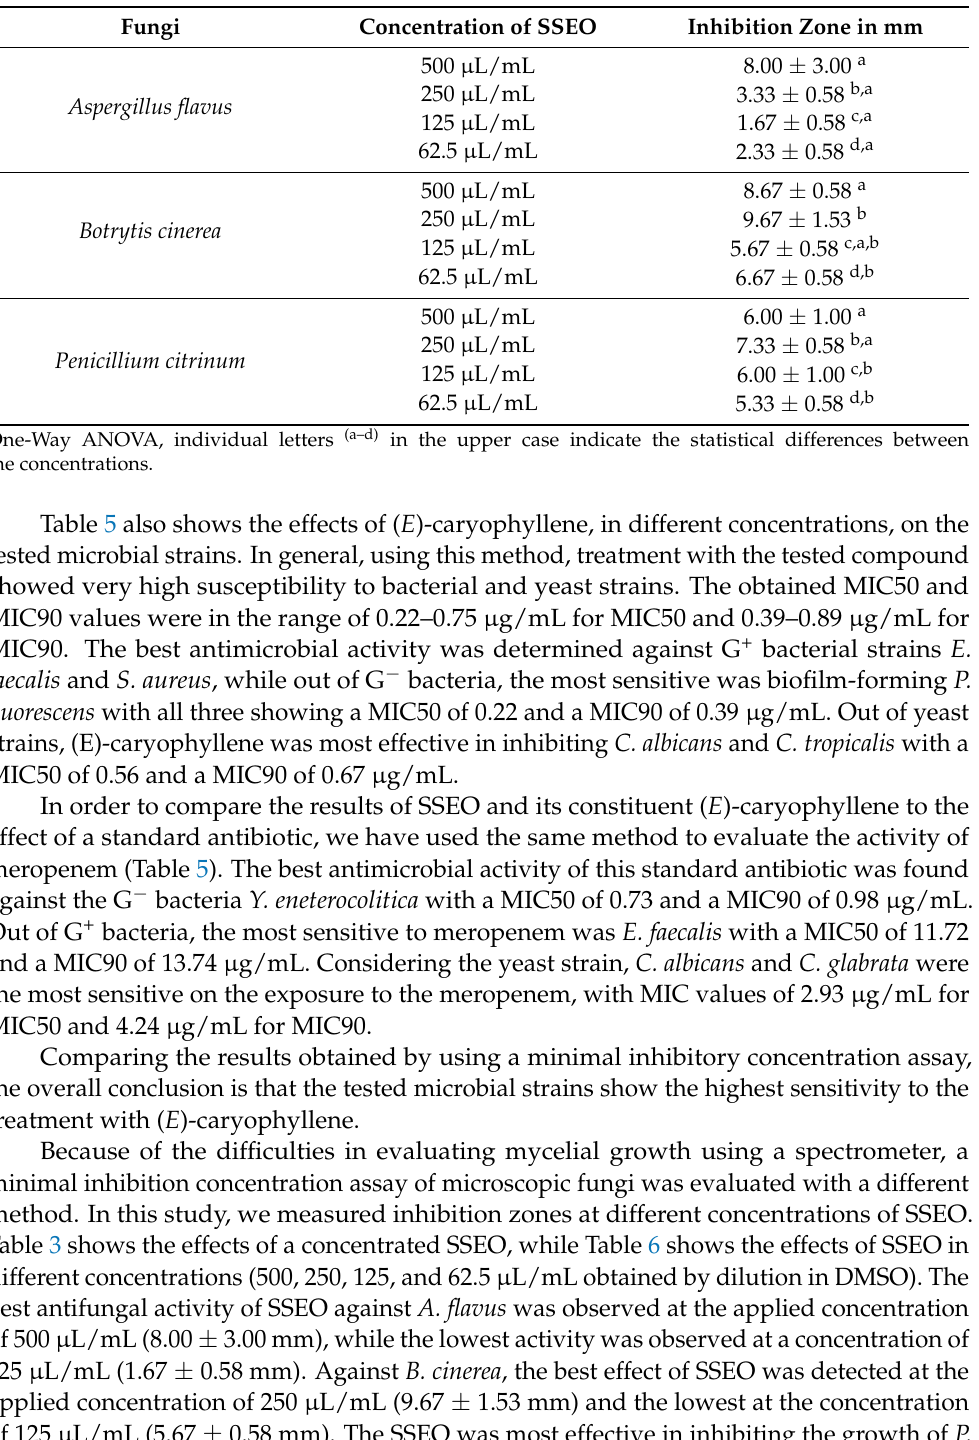
Table 6. Minimal inhibition concentration of microscopic fungi in